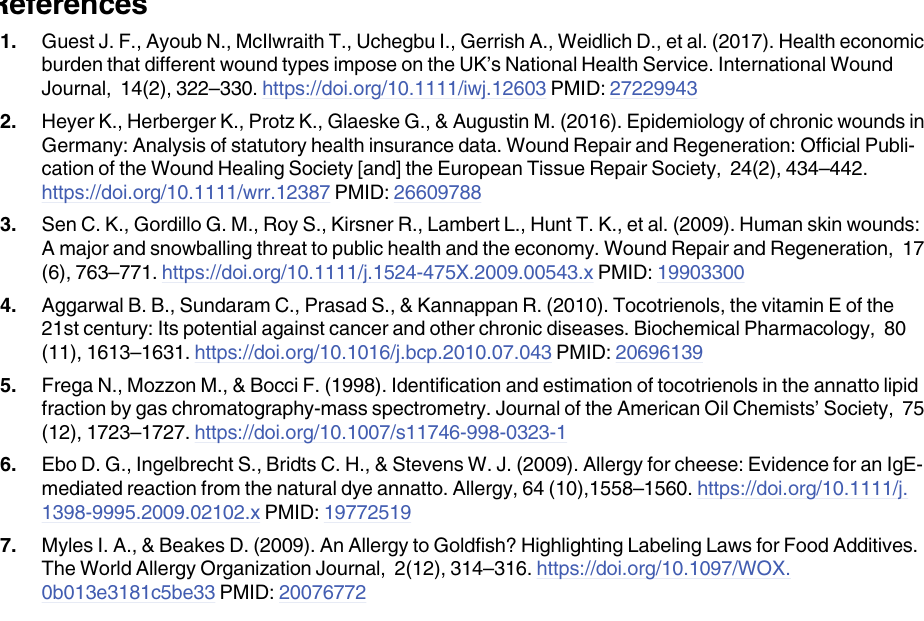
S1 Fig. Size distribution intensity at Day 0 of (A) full nanoemulsions (B) nanoemulsions with- out glycerol and (C) emulsion without glycerol and surfactant blend. (DOCX) S2 Fig. HPLC chromatogram of full nanoemulsion at Day